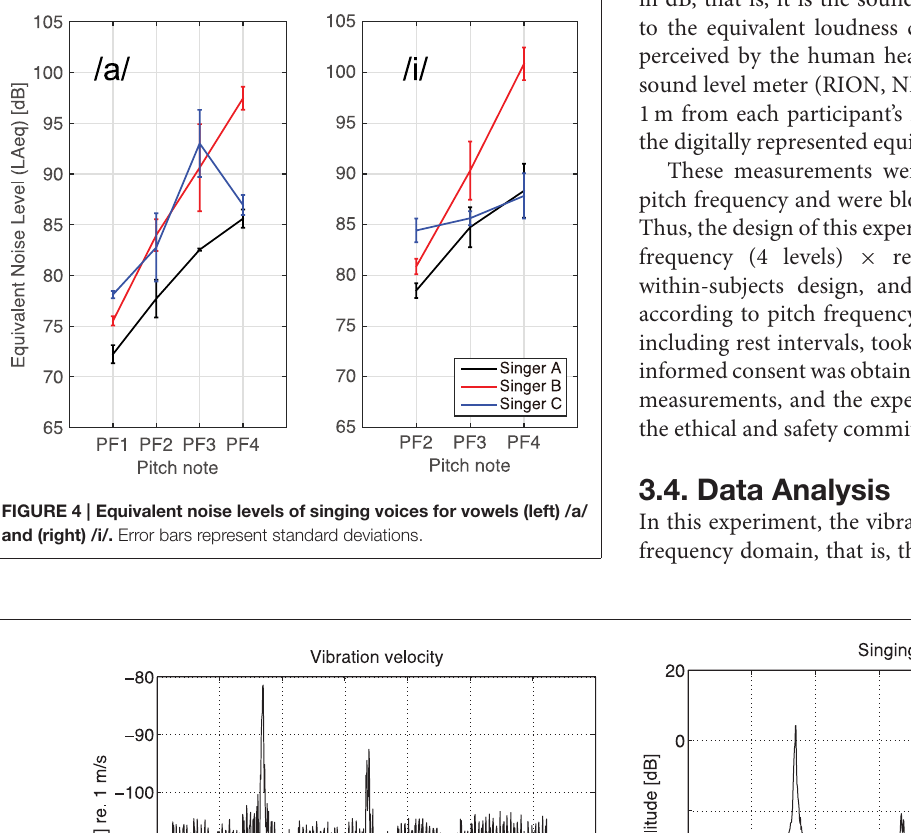
Frontiers in Psychology |